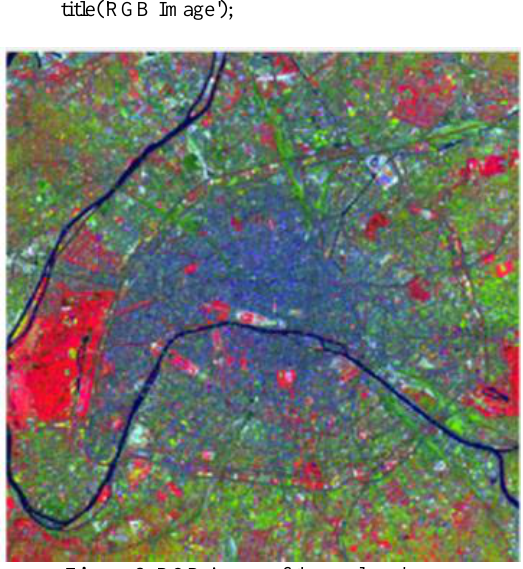
Figure 8. RGB image of the analyzed area.